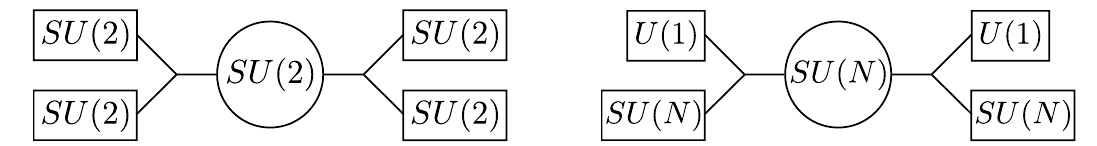
Figure 2 . Left: quiver diagram corresponding to the Liouville four-point function on the sphere. Right: quiver diagram corresponding to the A N (cid:0) 1 Toda four-point function on the sphere. The two SU( N ) (cid:13)avour groups correspond to full punctures on the Riemann surface, while the two U(1) factors correspond to simple